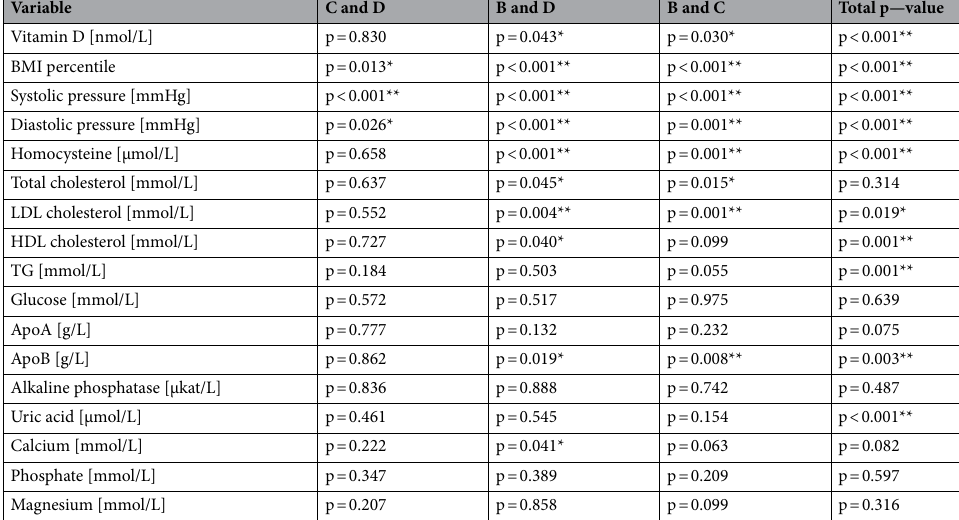
Table 3. Comparison of the variables with the independent samples t-test between all the groups. In the last column total p value represents the difference between the control group and all the studied groups combined. Children with hypertension (B), overweight children with hypertension (C) and overweight children with normal blood pressure (D). BMI Percentile body mass index percentile, LDL cholesterol low-density lipoprotein cholesterol, HDL cholesterol high-density lipoprotein cholesterol, TG triglycerides, ApoA apolipoprotein A1, ApoB apolipoprotein B. *p < 0.05, **p < 0.01.